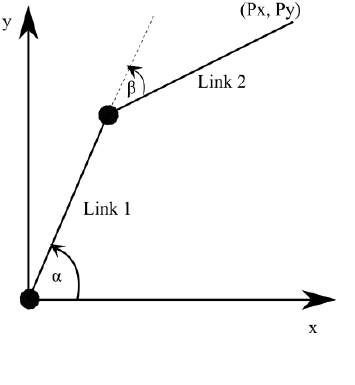
Figure A1. Base coordinates of robot